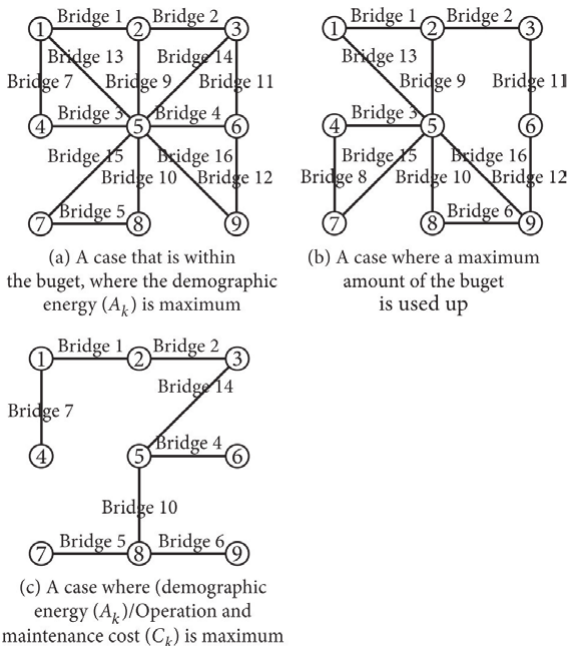
Fig. 5. Bridge decommission example (Radial network, Scenario 1)